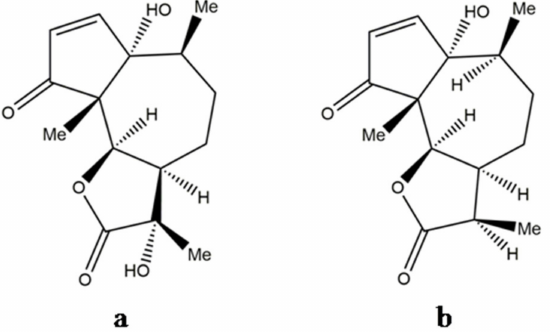
Figure 7. ( a ) C-11 hydroxylation product of parthenin and ( b ) C-11 reduction product of